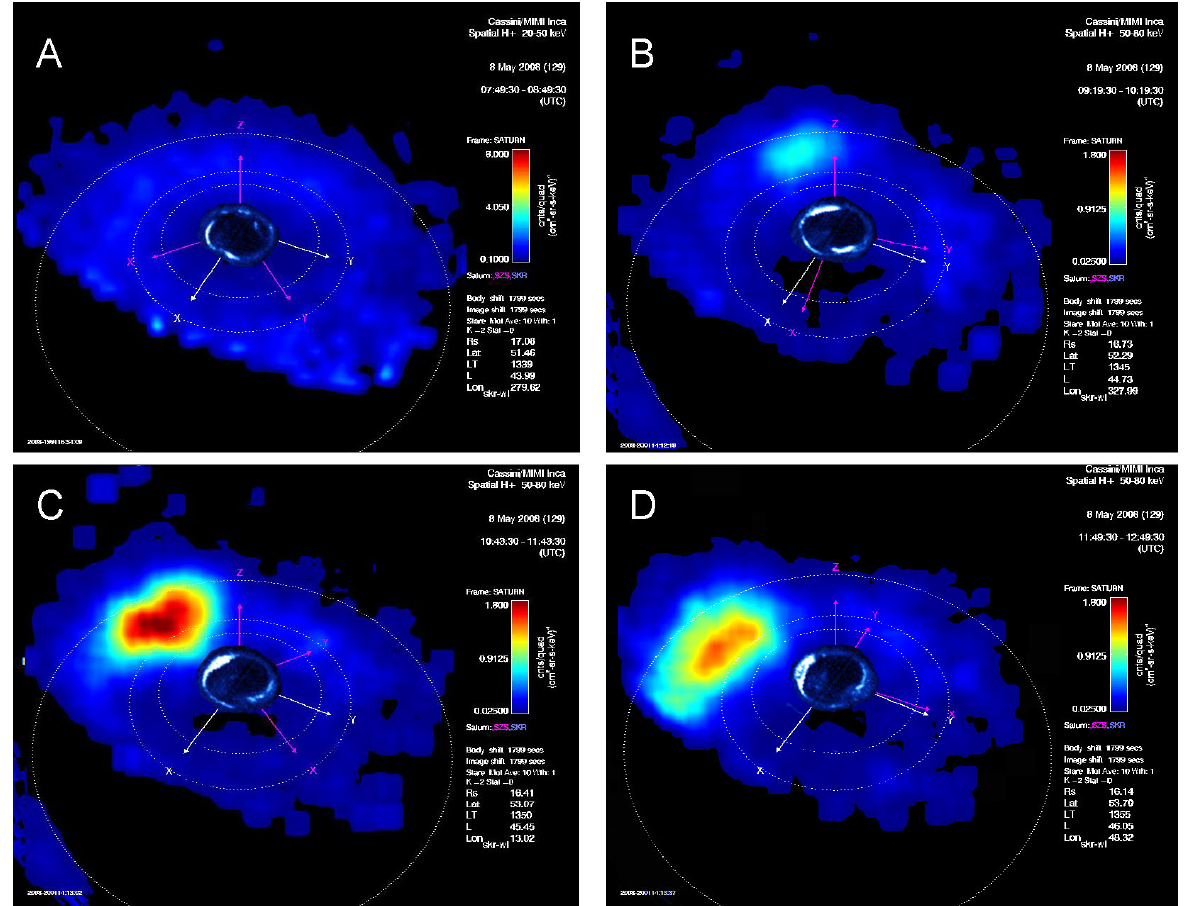
Figure 8. ENA images of Saturn’s magnetospheric ions and auroral EUV emissions during an particle acceleration event on 8 May 2008 (( A ) 0749–0849UT, ( B ) 0919–1019UT ( C ) 1043–1143UT, ( D ) 1141– 1149UT). Currents along the magnetic field accelerate the particles producing the aurora. (Figure courtesy of Donald Mitchell, a movie of the ENA images can be found at https://doi.org/10.17189/1 519607, accessed on 30 October